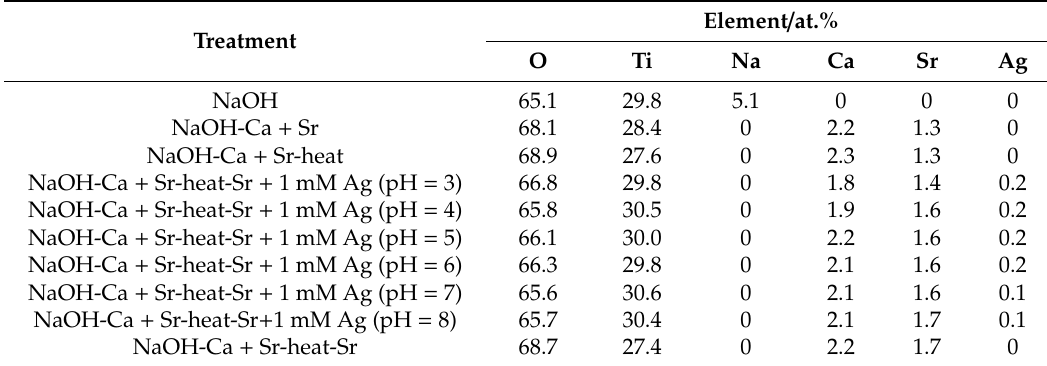
Table 2. The results of EDX analysis on the surface of Ti subjected to Sr + 1 mM Ag treatment with various pH following NaOH, Ca + Sr and heat